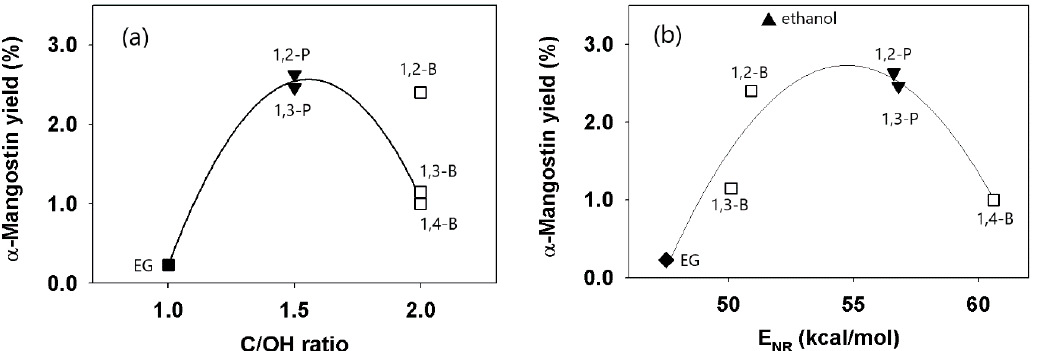
Figure 4. Extraction yield as a function of: ( a ) the C/OH ratio of the polyalcohols, and, ( b ) polar parameter E NR of the DESs. (ChCl:polyalcohol mole ratio of 1:3, legend signifies the HBD of the DES).